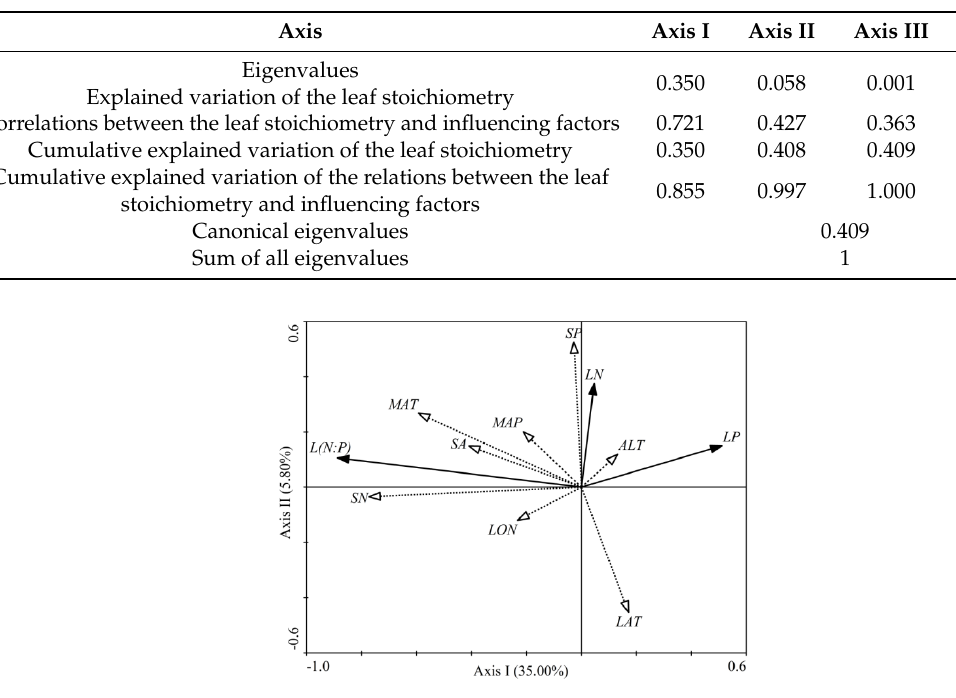
Figure 6. Bidimensional ordering chart of the RDA for the relationships between the leaf stoichiometry and influencing factors. LN is the leaf N concentration; LP is the leaf P concentration; L(N:P) is the leaf N:P ratio; SA is the stand age; LAT is the Latitude; LON is the Longitude; ALT is the Altitude; MAT is the mean annual temperature; MAP is the mean annual precipitation; SN is the soil N concentration; and SP is the soil P concentration. The leaf stoichiometry and influencing factors are represented by the solid and dotted line, respectively. The length of the arrow line represents the correlation level between the leaf stoichiometry and influencing factors. A longer line indicates a higher correlation. The angel between the two arrow lines can be considered an evaluation of the correlation level between the leaf stoichiometry and influencing factors. An angle between 0 and 90 degrees indicates a positive correlation between the two variables; an angle between 90 and 180 degrees indicates a negative correlation between the two variables shown; and an angle of 90 degrees shows no relationship between the two